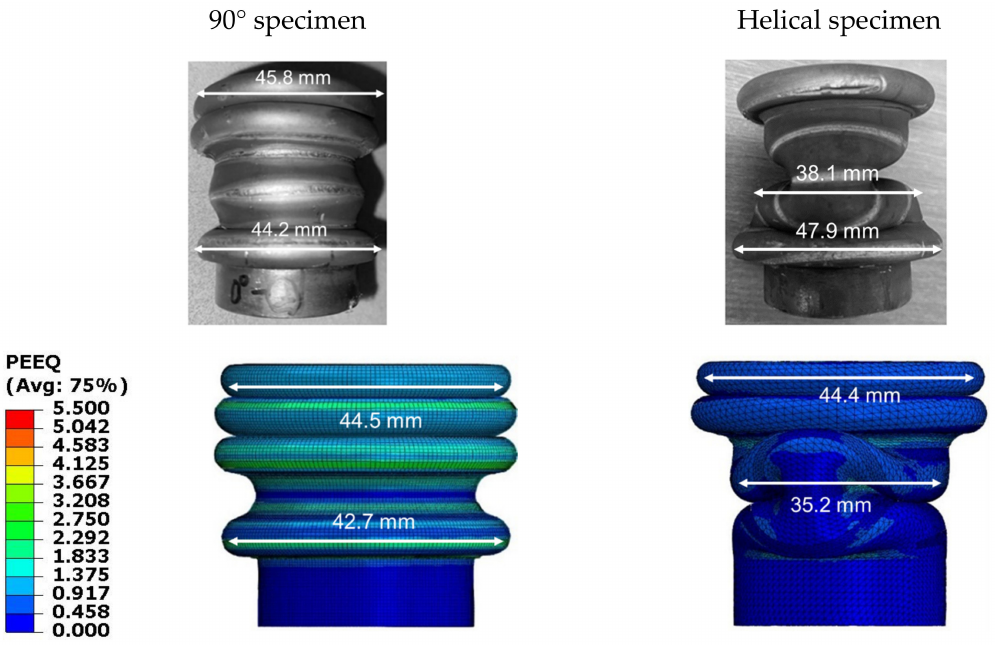
Figure 15. Deformation mode in FEM analysis.